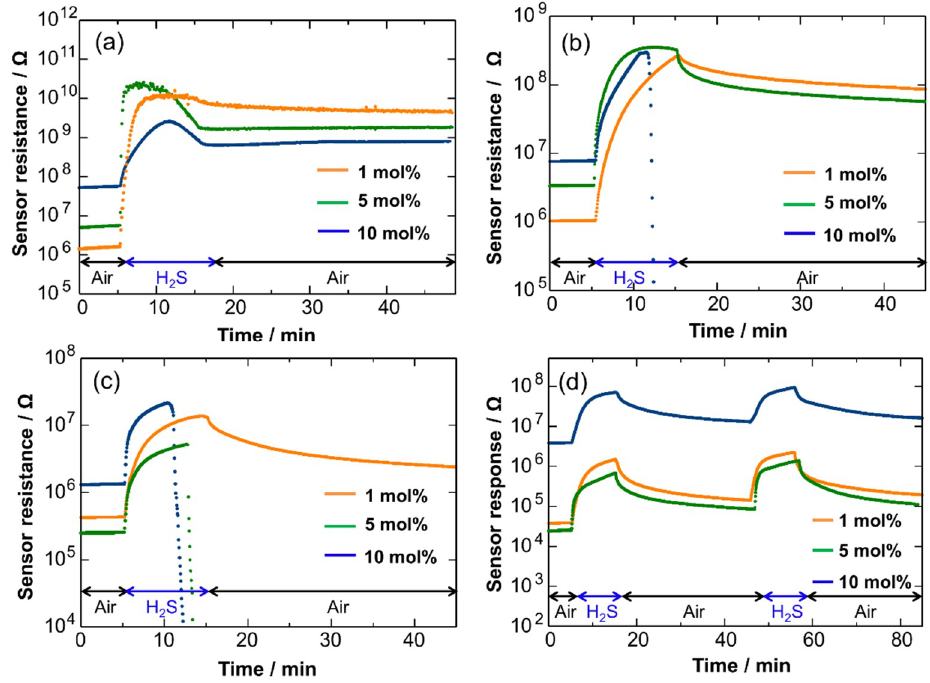
Figure 9. Response transients to 8 ppm H 2 S in air for Pd-loaded (1, 5, 10 mol%) Cu 2 O NC sensors at different temperatures. ( a ) 50, ( b ) 100, ( c ) 150, ( d ) 200 °C.